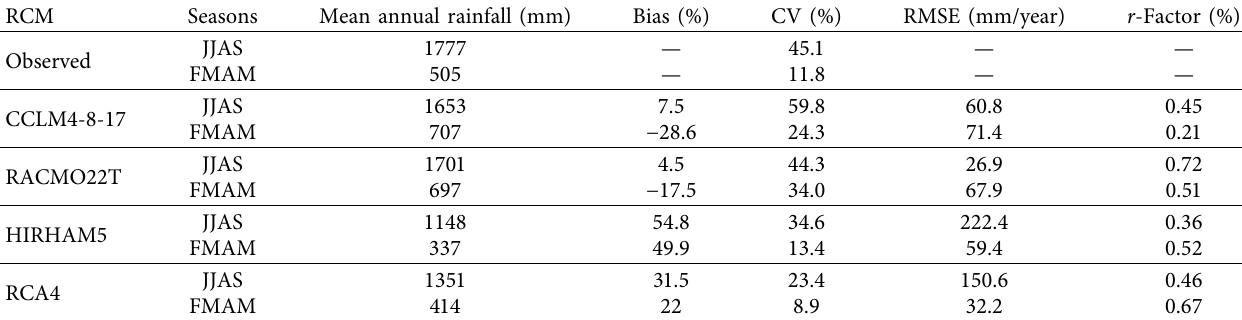
Table 9: Performance of RCMs in reproducing annual precipitation based on statistical parameters. RCM